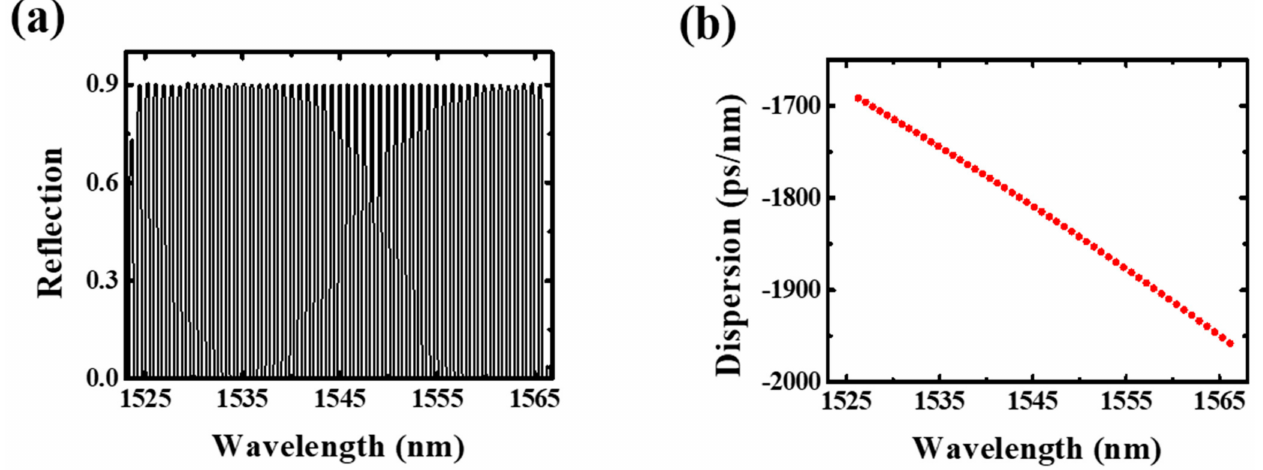
Figure 23. Design results for a 51-channel FBG-based dispersion and dispersion compensator. ( a ) Re- flection spectrum of the 51-channel. ( b ) Dispersion spectrum of the 51-channel. Adapted with permission from ref. [115]. © The Optical